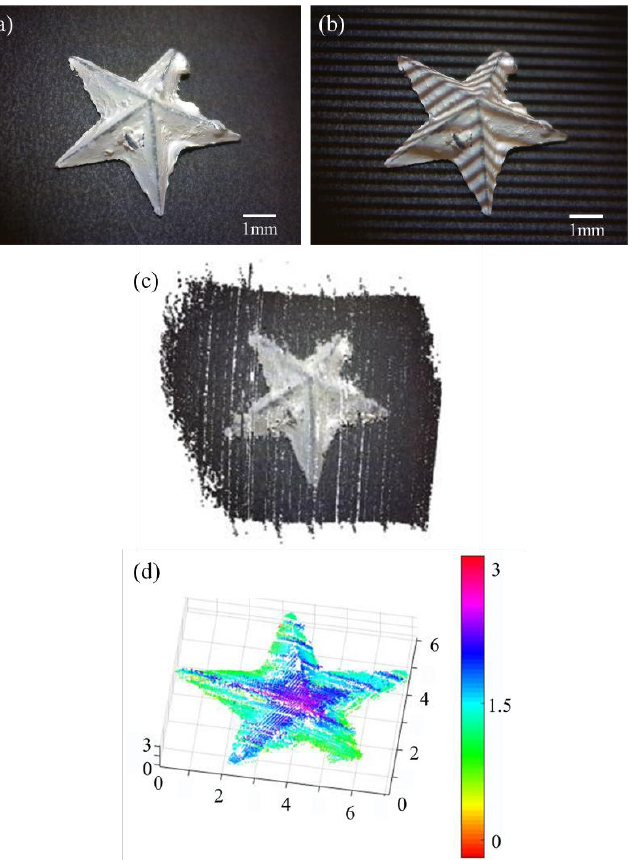
Figure 3. Experimental results of a 3D printed star. ( a ) Original 2D image of the star. ( b ) Image of the star illuminated with structured light. ( c ) Reconstruction point cloud of the star. ( d ) Heatmap that shows the depth and height information of the star. The x, y and z scales are in the unit of millimeters.